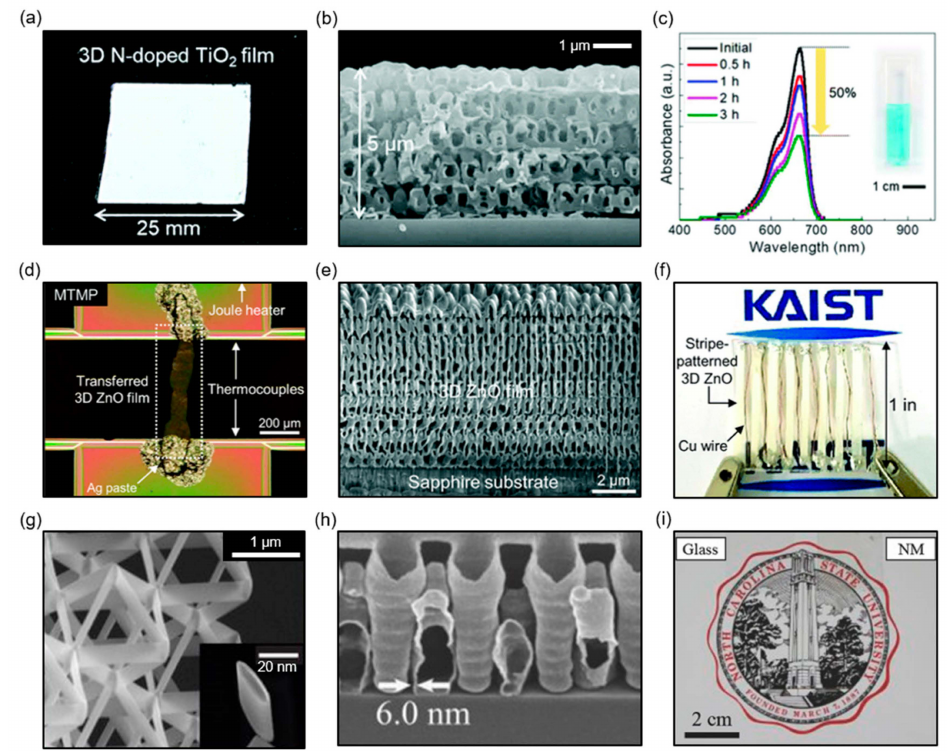
Figure 7. Application of highly porous inorganic materials with a hollow 3D nanonetwork structure: ( a ) digital image of a large-area (625 mm 2 ), 3D nanonetwork-structured, N-doped TiO 2 film produced by PnP and ALD; ( b ) cross-sectional SEM image of (a); ( c ) photocatalytic degradation of methylene blue solution under solar irradiation (reprinted with permission from [22]. Copyright 2018 The Royal Society of Chemistry); ( d ) optical microscope image of a 3D nanonetwork-structured ZnO film transferred on a microfabricated thermoelectric measurement platform (MTMP); ( e ) cross-sectional SEM image of (d); ( f ) digital image of a thermoelectric device prototype based on 3D nanonetwork-structured ZnO stripes (reprinted with permission from [27]. Copyright 2018 The Royal Society of Chemistry); ( g ) SEM image of an abnormally resilient 3D nanonetwork-structured TiN film produced by DLW and ALD (reprinted with permission from [15]. Copyright 2013 Nature Materials); ( h ) cross-sectional SEM image of a 3D nanonetwork-structured Al 2 O 3 film with a thickness of 6 nm; ( i ) digital image of a highly transparent, 3D nanonetwork-structured Al 2 O 3 film coated on a glass substrate (reprinted with permission from [29]. Copyright 2015 John Wiley and